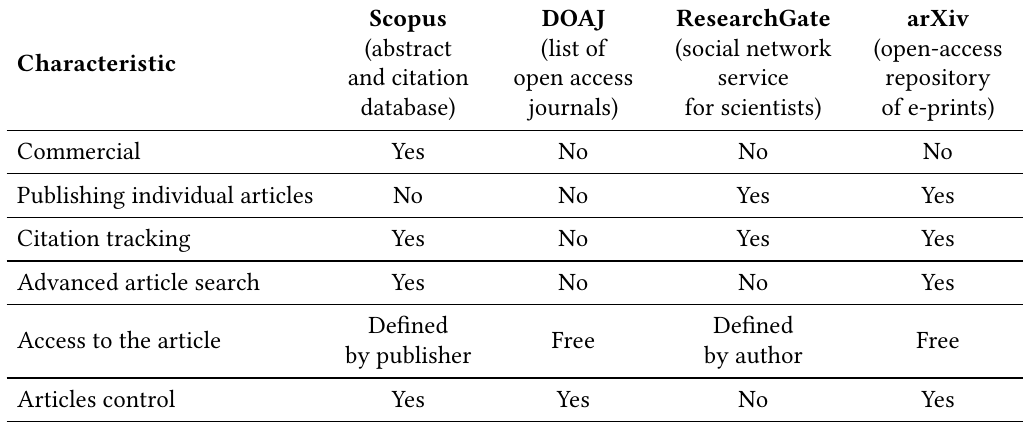
Table 4 Comparing the tools for publishing scientific